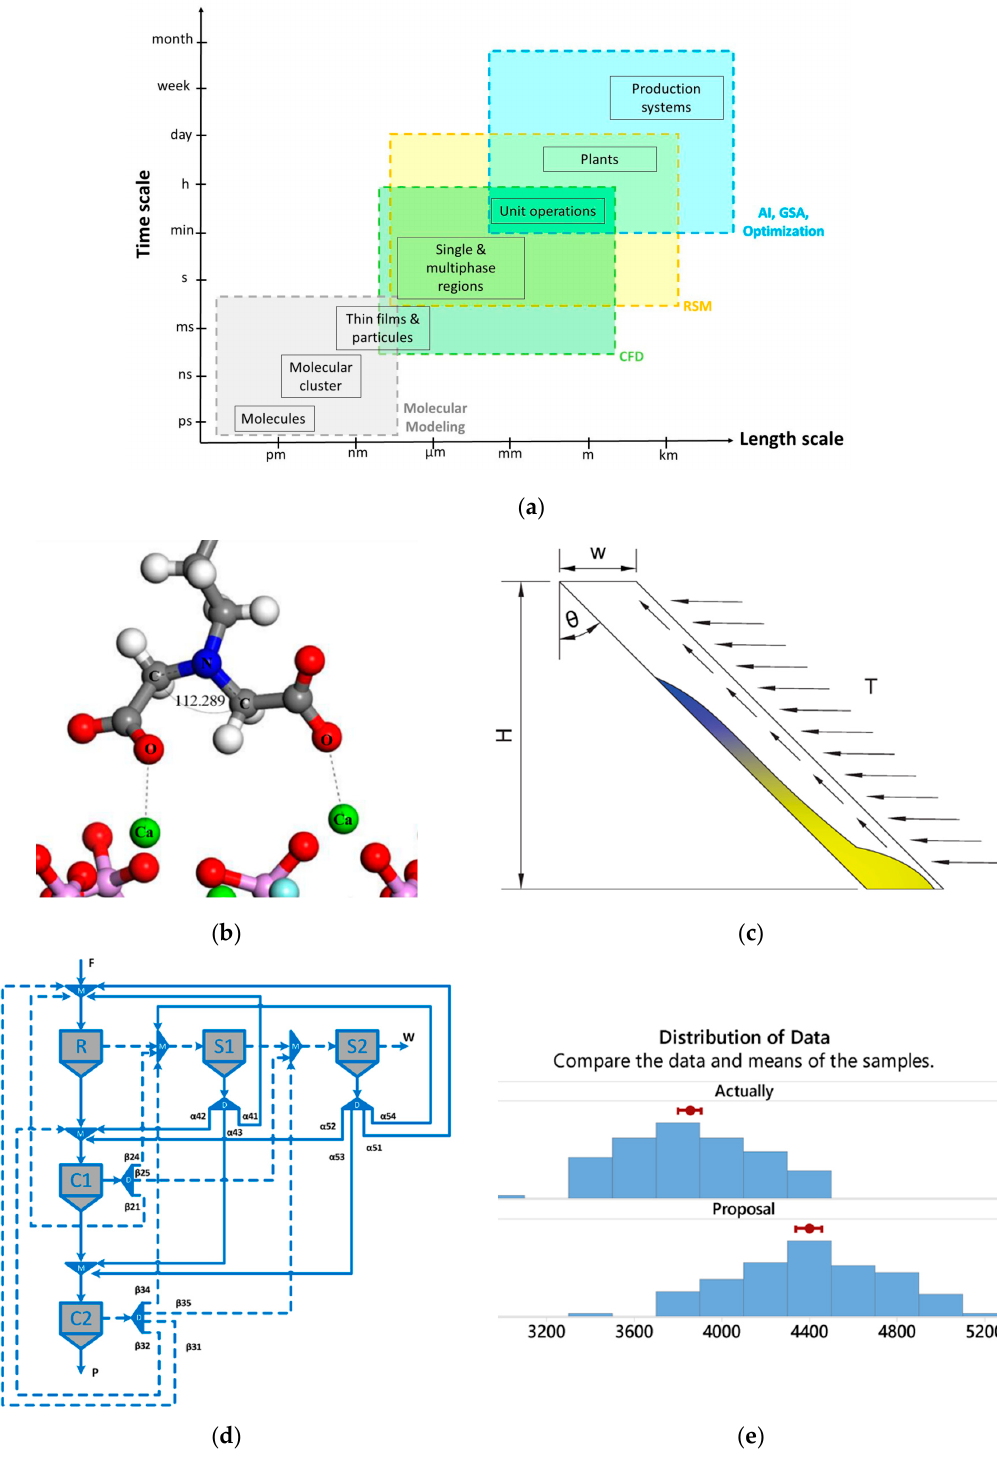
Figure 1. Figures from the special issue. ( a ) Levels of length and time alongside the modeling and optimization tools [4]; ( b ) Adsorption configuration of collector N-(carboxymethyl)-N-tetradecylglycine on fluorapatite. (Ca—green; phosphorus—purple; O—red; H—white; fluorine—light blue; N—dark blue) [14]; ( c ) Scheme of the inclined settler [17]; ( d ) Superstructure for flotation circuit design [18]; ( e ) Production comparison between strategies that do and do not consider changes in the manner of operation [19].